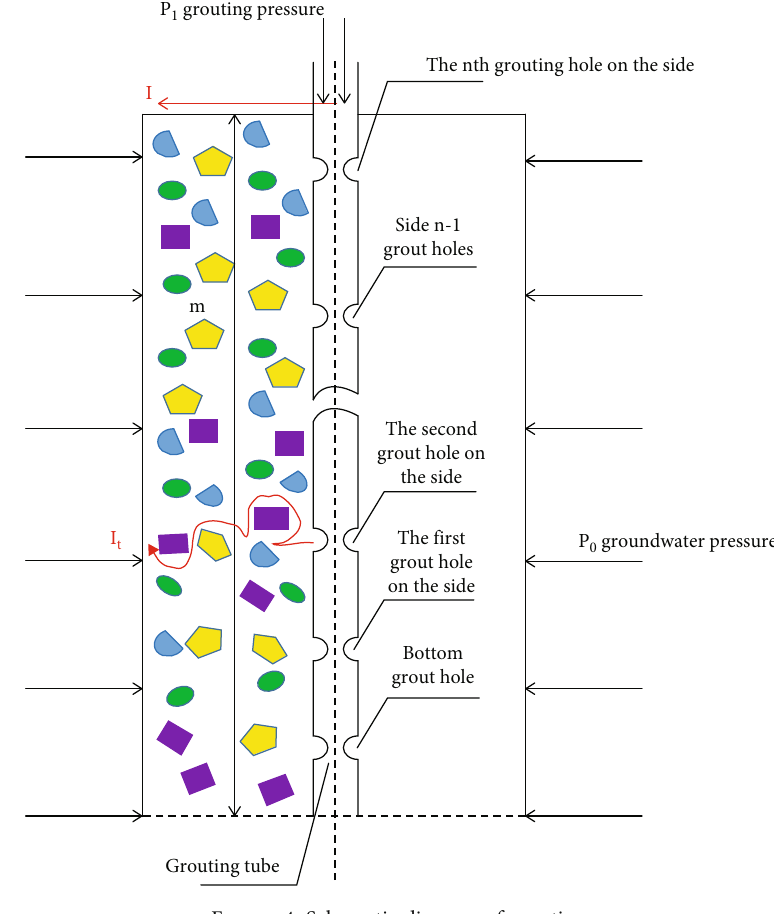
Figure 4: Schematic diagram of grouting.